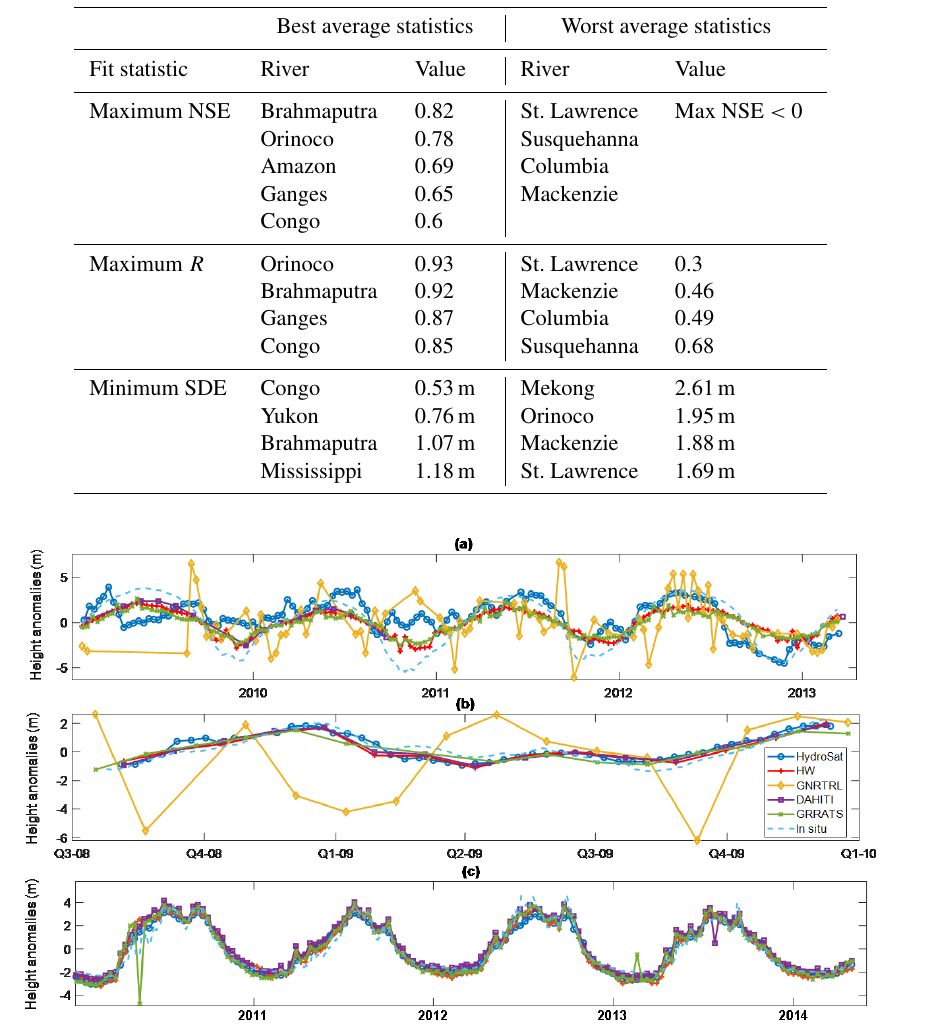
Table 3. River average fit statistics.